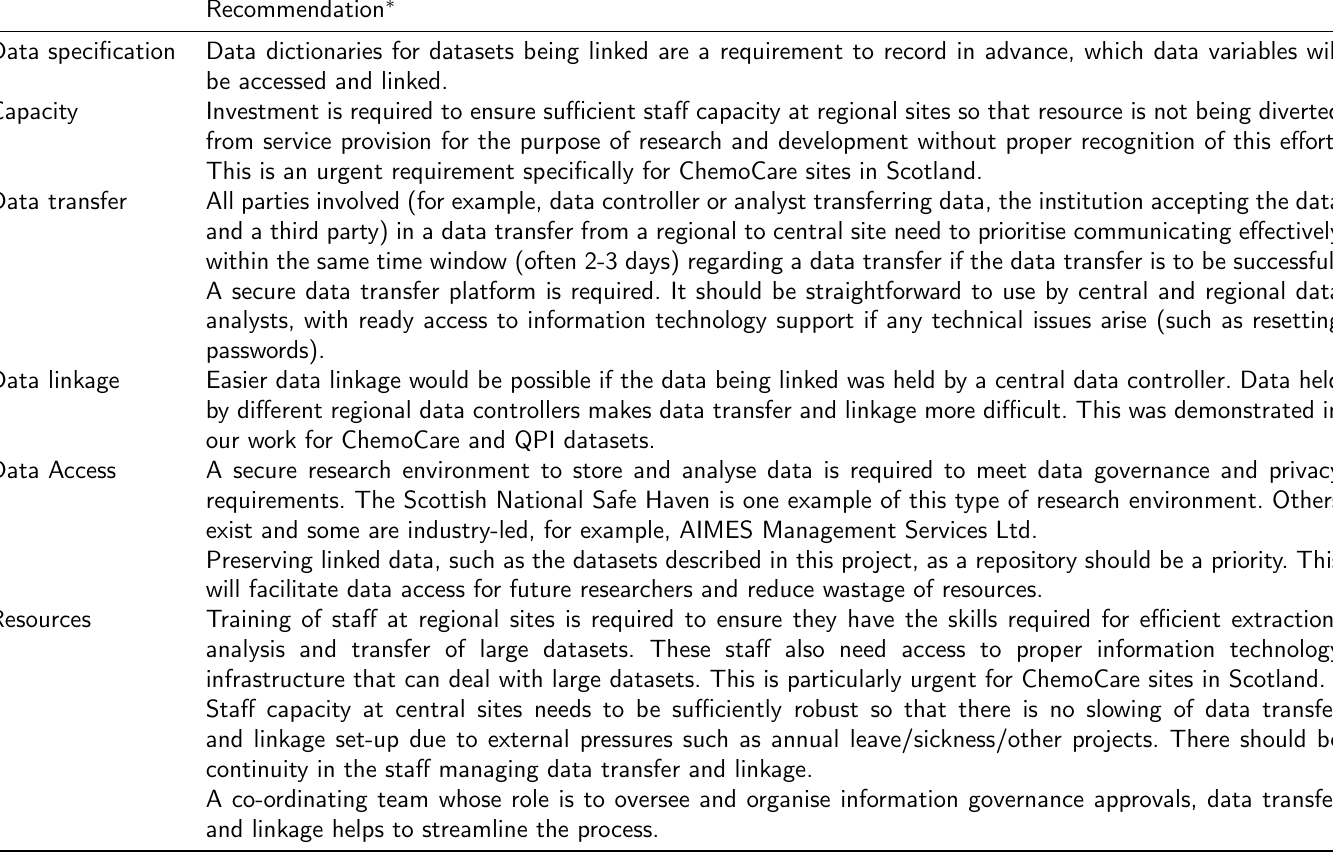
Table 2: Recommendations for creating a linked healthcare